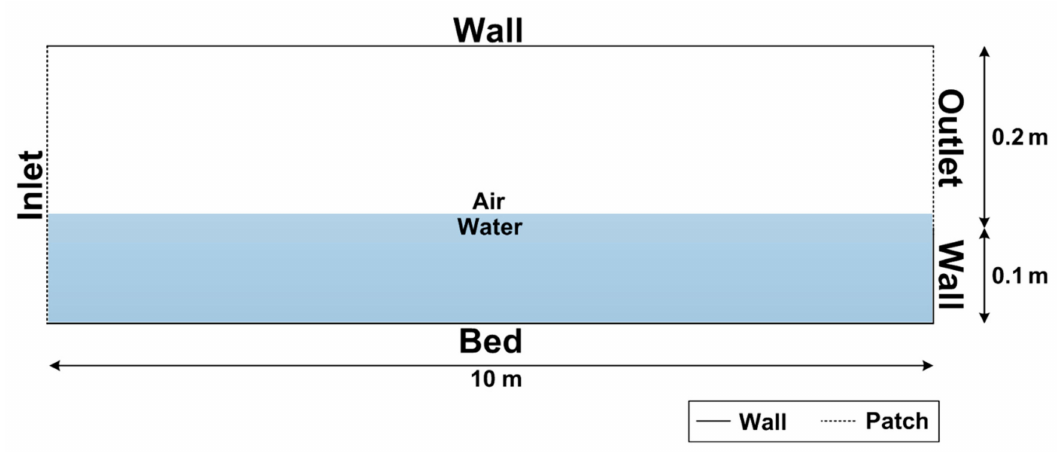
Figure 3. Conceptual diagram of the A Coruña pilot sewer mesh illustrating the boundary definitions and water level. Please note that this diagram is not to